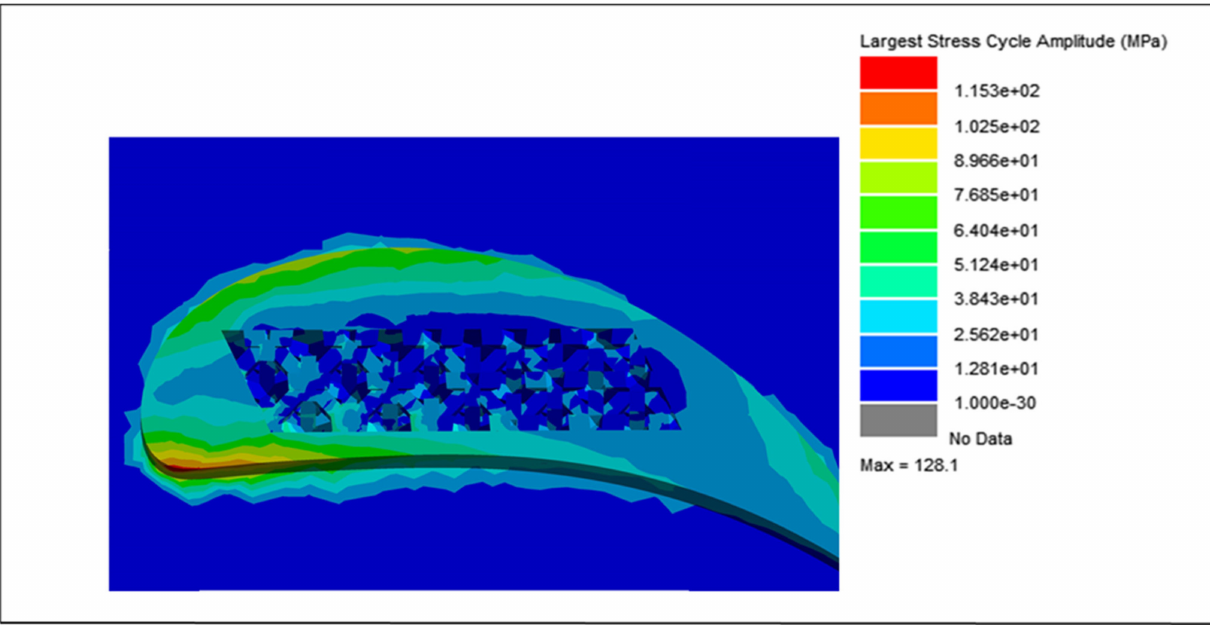
Figure 19. Largest stress cycle amplitude for the 0.75 mm lattice